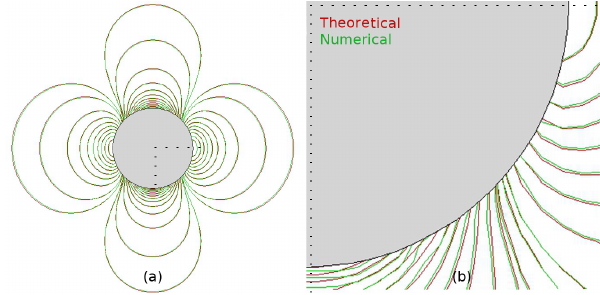
Figure 10. Potential solution around a sphere: (a) kinetic energy in an arbitrary symmetry plane; (b)